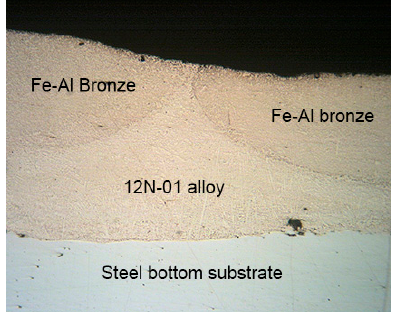
Figure 12. The cross-section of single composite layer (50x).